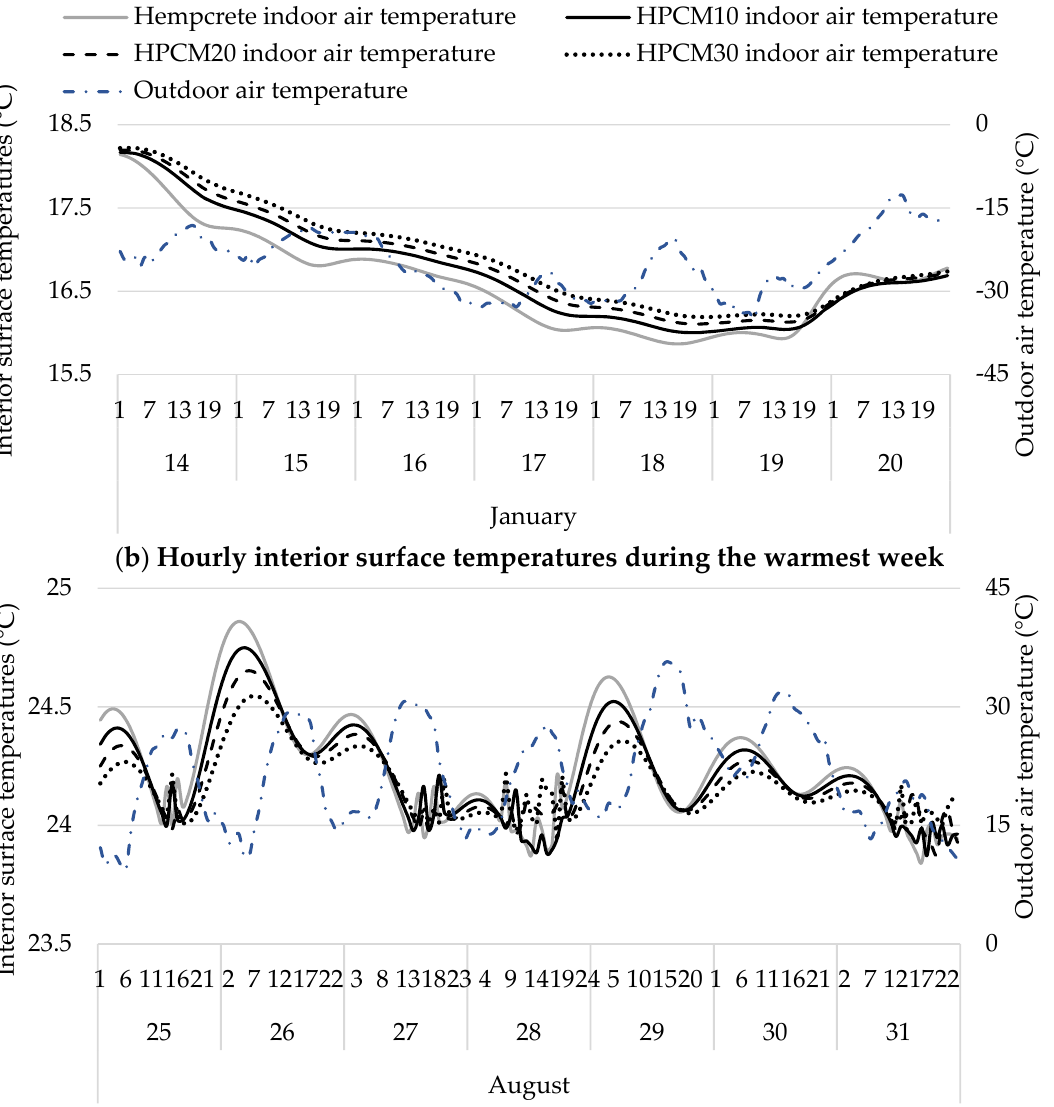
Figure 6. Interior surface temperatures of wall types during ( a ) coldest and ( b ) warmest weeks.